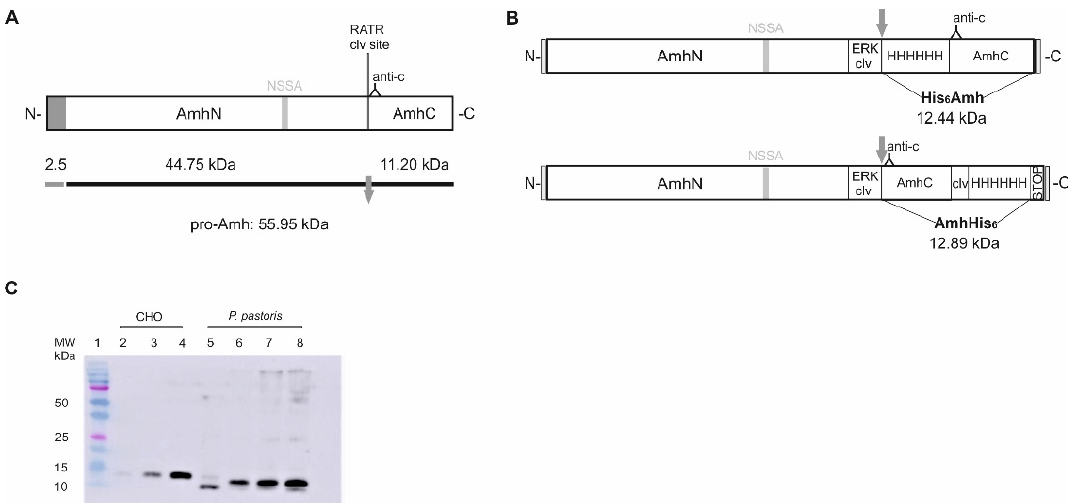
Figure 1. Sea bass anti-Müllerian hormone (Amh) proteins. ( A ) Structure of sea bass Amh preproprotein: Arg 426 -Ala-Thr-Arg (RATR) is the presumptive proprotein convertase cleavage site in the endogenous sea bass Amh. In agreement with the prediction results, the first 22 residues (2.5 kDa) correspond to the signal peptide (dark grey rectangle) and the Asn 321 in NSSA sequon is N -glycosylated. After signal peptide cleavage, pro-Amh has a MW of 55.95 kDa. Proteolytic processing of pro-Amh yields 44.75 kDa Amh N and 11.20 kDa Amh C domains. The position of the C-terminal peptide used for antibody production is illustrated (anti-c); ( B ) Engineered sea bass His 6 Amh and AmhHis 6 : sea bass Amh signal peptide was removed to clone the mature gene in frame and downstream of the α -factor signal sequence in the pPIC9K plasmid. The putative protease cleavage site was changed to an EKR site (ERK clv) to allow cleavage of the sea bass Amh proprotein by P. pastoris enzyme Kex2p. A His 6 -tag (HHHHHH) was placed before (pPICK9-His 6 Amh) or after (pPICK9-AmhHis 6 ) the mature peptide to facilitate the purification. AmhHis 6 also includes an IEGR site (clv), placed N -terminal of the His 6 -tag, for the removal of the affinity tag by the Factor Xa protease; ( C ) Recombinant sea bass Amh proteins: Known concentrations (1, 2 and 4 ng/ µ L) of sea bass Amh produced in CHO cells [30] (lanes 2–4) were used to infer the concentration of purified sea bass His 6 Amh (lane 5, 1 µ L) and AmhHis 6 (lanes 6–8, 1, 3 and 4 µ L) proteins produced in P. pastoris . A calibrated protein standard (in kDa) was used to estimate protein molecular weight